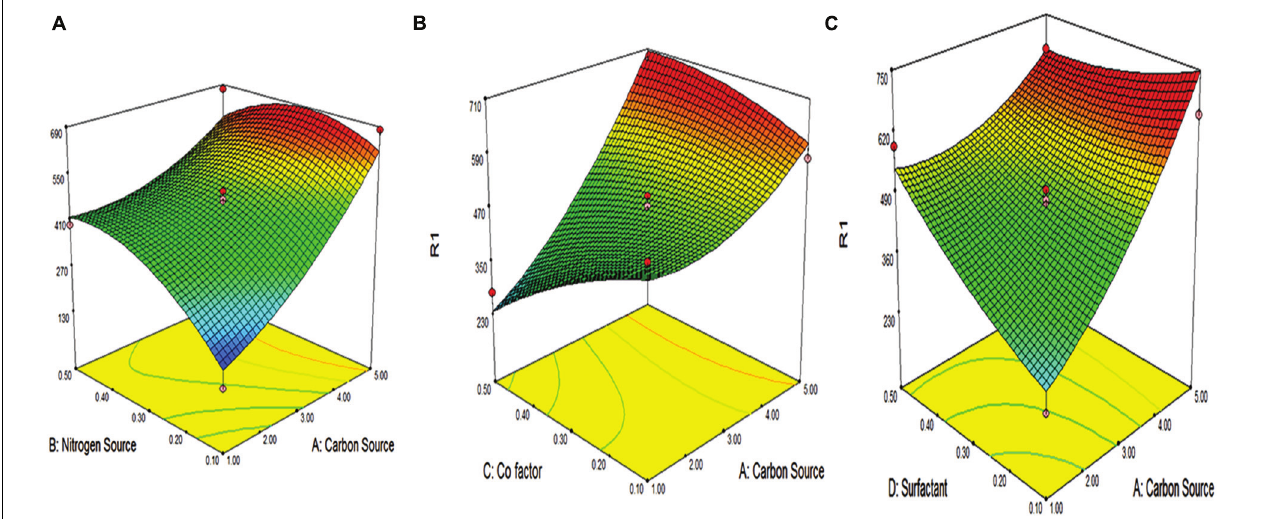
FIGURE 3 | Response surface plots of alkaline protease production showing interaction between (A) carbon and nitrogen source (B) carbon source and co factor (C) carbon source and surfactant.